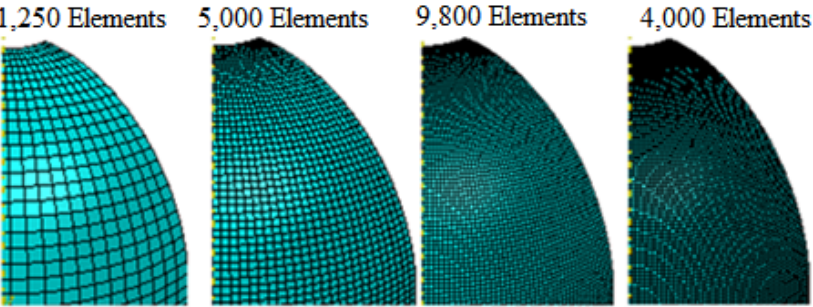
Figure 6. COPV implemented mesh densities for convergence